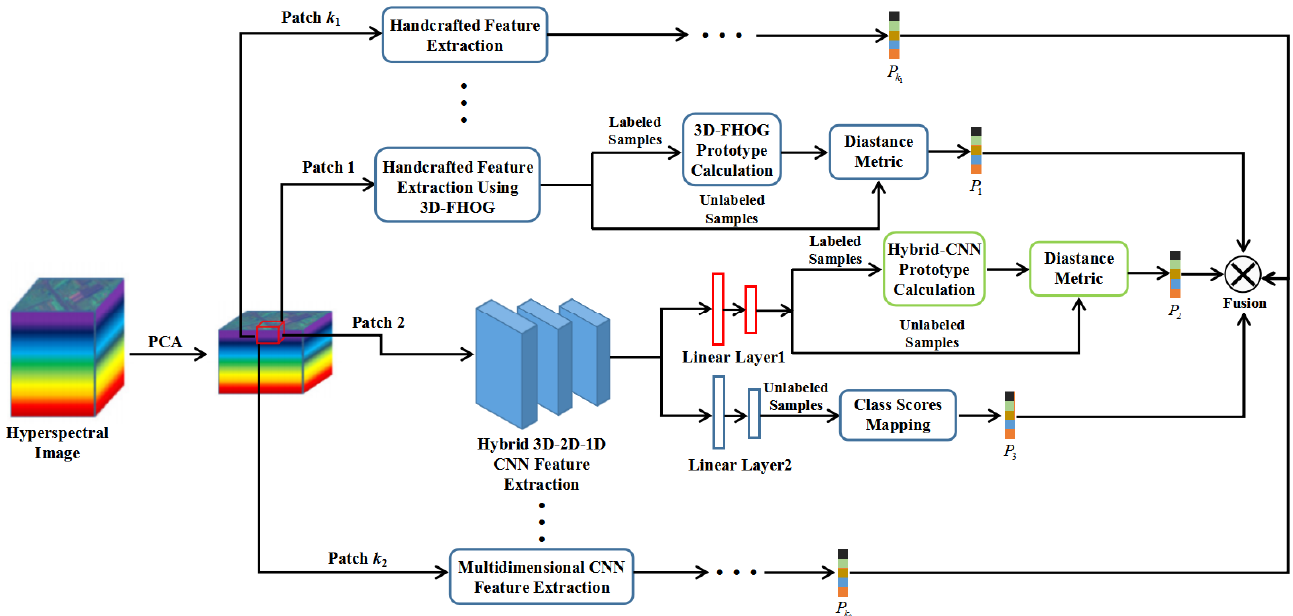
Figure 1. The fusion framework of multidimensional CNN and handcrafted features for small-sample HSI classification. Initially, 3D-FHOG is adopted as the handcrafted feature extraction method, and MDSN is utilized for multidimensional CNN-based feature extraction.